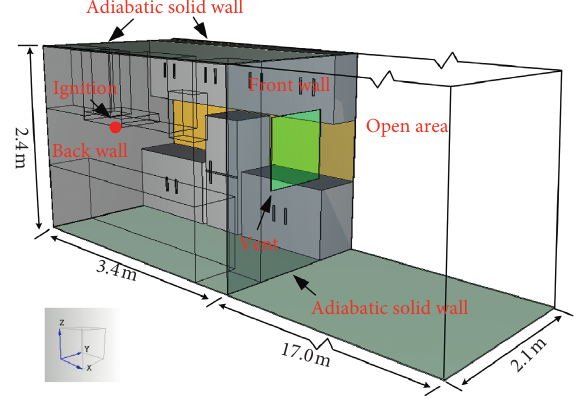
Figure 3: Physical model of the type II kitchen.